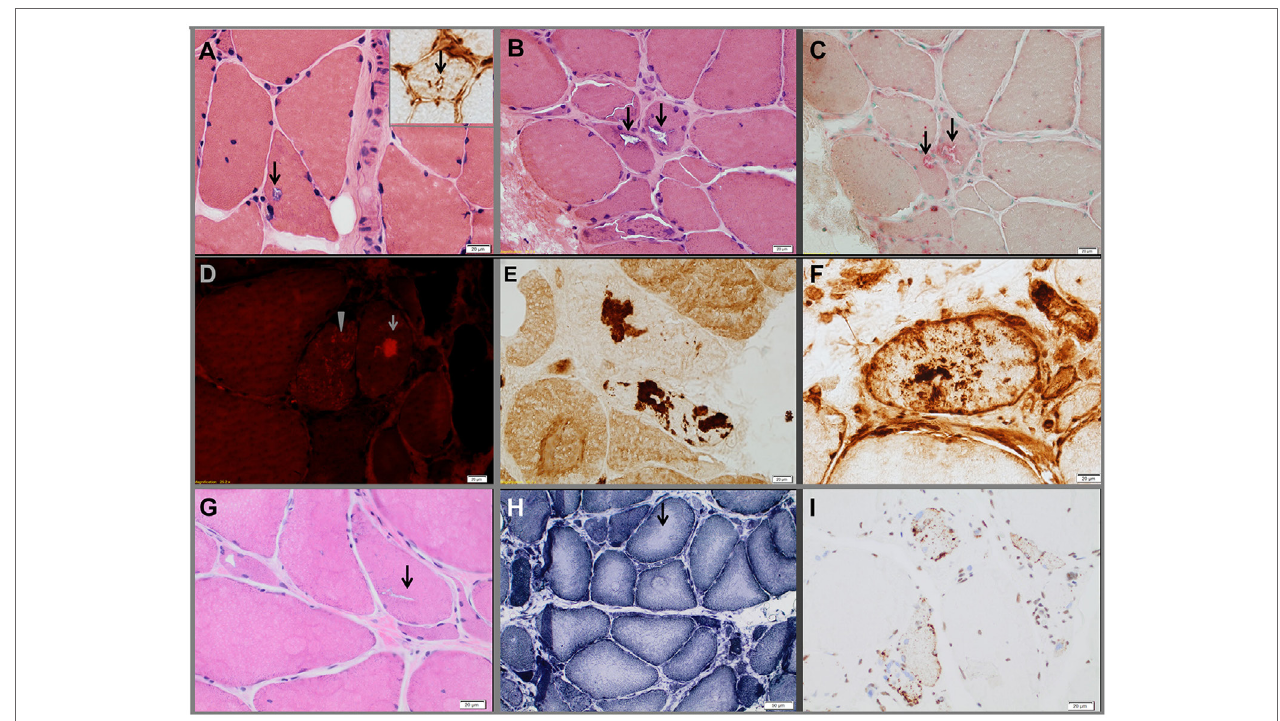
FigUre 3 | Muscle biopsies from the three probands. Proband 1 (a) . Hematoxylin-eosin-stained section demonstrating a vacuole (arrows) rimmed by membranous material. The insert in the upper right corner shows a TIA1-positive inclusion within a vacuole. Proband 2 (B–F) . Hematoxylin-eosin-stained section (B) showing rimmed vacuoles (arrows), which strongly overreact for acid phosphatase (c) . Extravacuolar large (arrow) or small congophilic inclusions (bright red dots within muscle fiber pointed by arrow head) (D) are present in structurally abnormal fibers (congo red stained section viewed under rhodamine optics). Several fibers demonstrated focal accumulation (dark stain) of myotilin [ (e) , representative fiber], TIA1 [ (F) , representative fiber], alpha-B crystallin, and desmin (data not shown). The pathological findings are suggestive of myofibrillar myopathy. Proband 3 (g–i) , hematoxylin-eosin-stained section showing chronic myopathic changes and rimmed vacuoles (arrow) (g) . NADH-TR-stained section revealing “rubbed-out” areas of decreased oxidative enzyme reactivity (arrow, representative fiber) in multiple myofibers (h) . Several fibers demonstrating mislocalized cytoplasmic granules of TDP-43 staining (dark stain) (i)